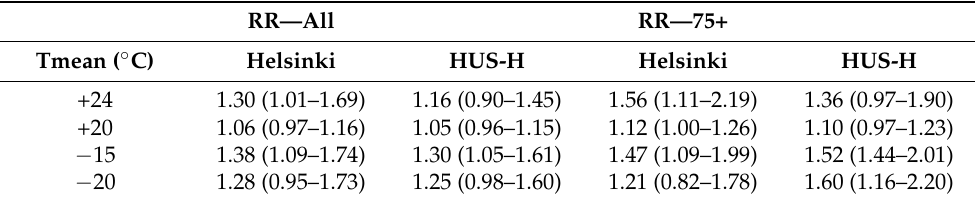
Table 1. Relative risks (RR) of all ages and 75+ mortality (with 95% confidence interval) at selected daily mean temperatures (Tmean) in Helsinki and in the surrounding Helsinki-Uusimaa hospital district (HUS-H) based on modelled temperature–mortality relationship 2000–2018.